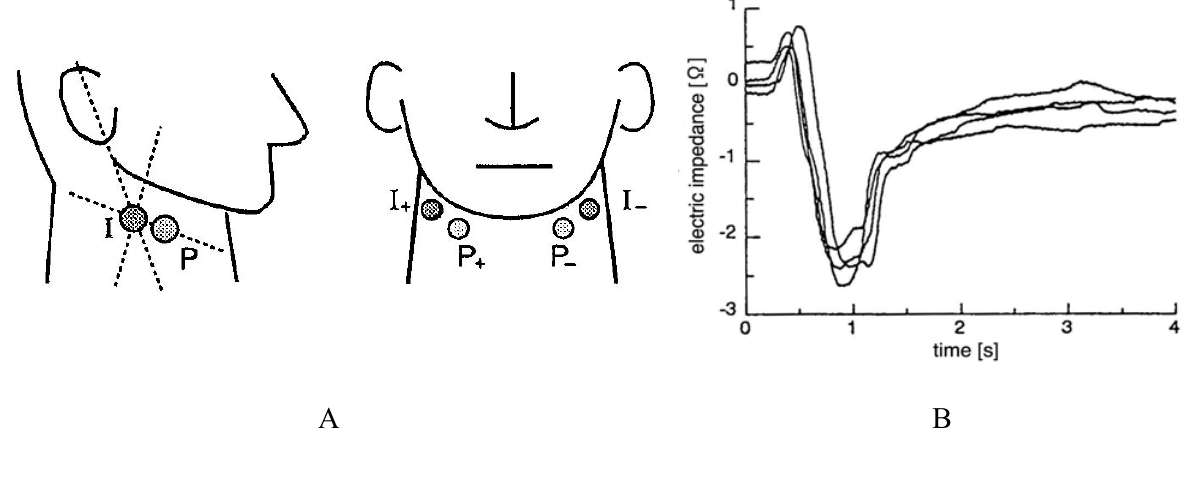
Figure 18. Impedance pharyngography [60]. A: position of the four electrodes, denoted as , P , I and P , attached to the neck skin surface. B: change in electric impedance over I + + - - time during